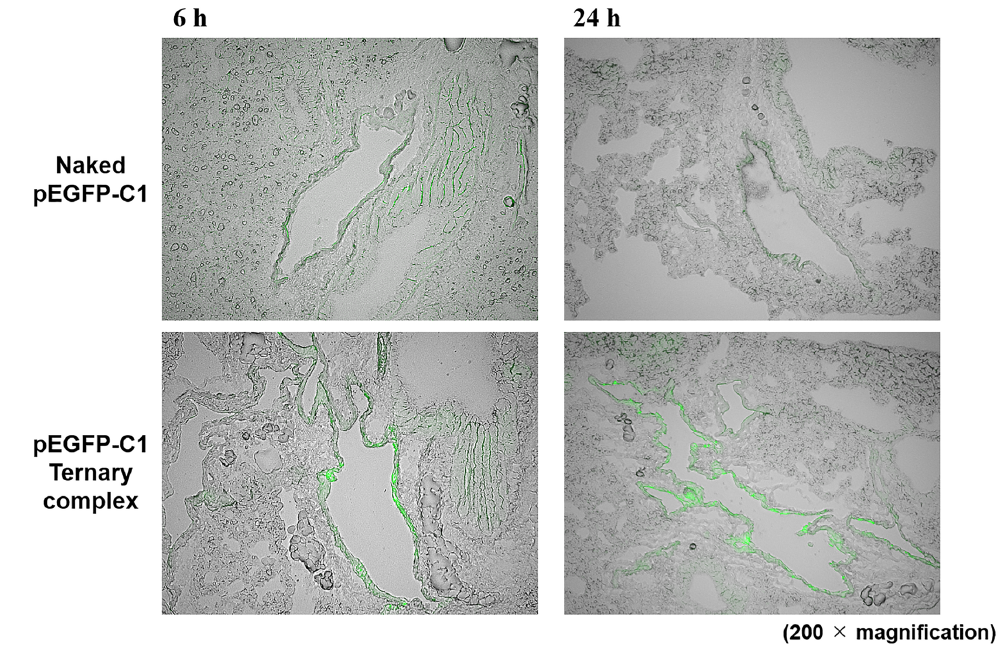
Figure 2. Preparation and observation of lung sections. Naked pDNA and the pEGFP-C1 ternary complex were administered by the intrapulmonary route to mice. Mice were sacrificed 6 or 24 h later and the lungs were harvested and processed. Fluorescence was visualized using fluorescent microscopy.